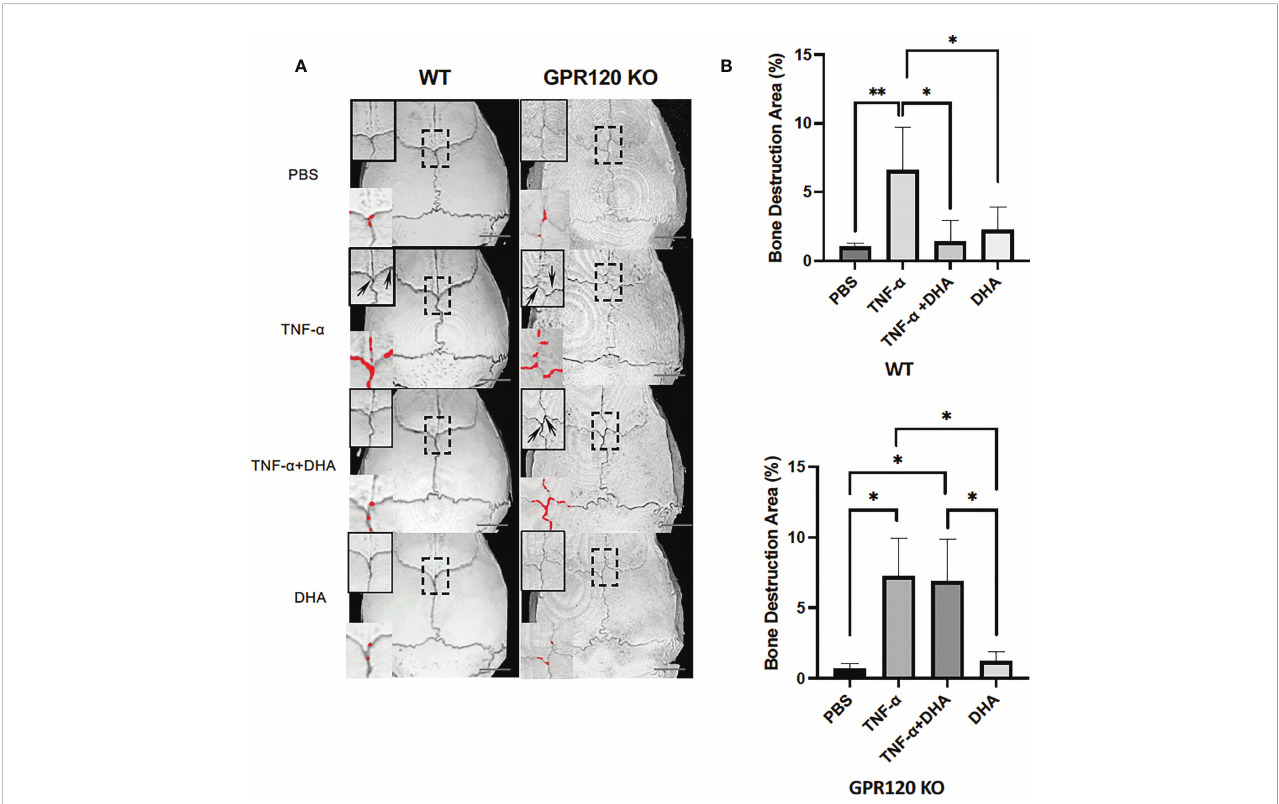
FIGURE 2 DHA inhibited TNF- a -induced bone resorption in vivo . (A) Three-dimensional reconstructed images of WT and GPR120 mouse calvariae. After receiving daily injections of PBS, TNF- a , TNF- a + DHA, or DHA only for 5 days, calvariae were resected and scanned using micro-CT. Three-dimensional images were created using TRI/3DBON64 software. Bone destruction areas are indicated by red dots and upper left corner zoom in of each image with arrows. (B) The ratio of bone destruction area to total calvarial bone area in WT and GPR120-KO mice. The results are given as means ± SD. Scheffe ́ ’ s test was used to determine the statistical signi fi cance of differences (n = 4; * p < 0.05, ** p < 0.01) Scale bars = 2